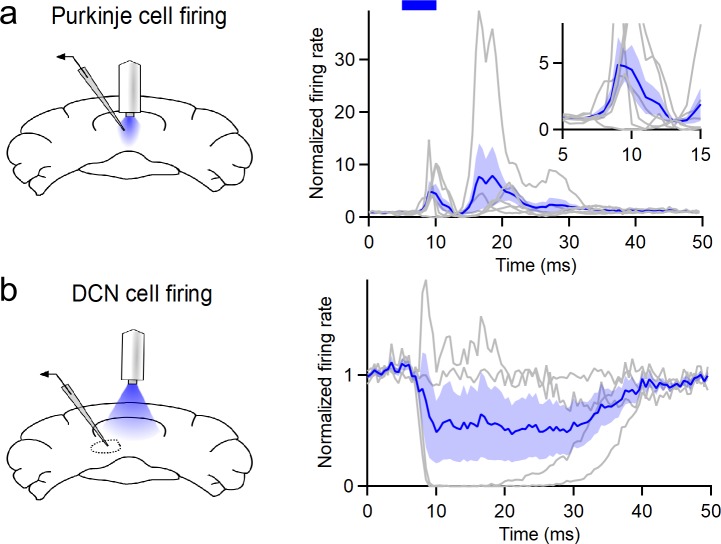
Millisecond-scale analysis of firing rates induced by in vivo stimulation in PCP2-cre::Ai32 animals.(a) Peristimulus time histogram (0.5 ms bins) of Purkinje cell firing induced by optical stimulation (20 Hz, 5 ms flashes). Inset shows PC responses from the beginning of light onset. (b) As in (a), but for DCN recordings. These recordings represent the same data shown in Figure 1. Individual units are in gray, the mean ± SEM is displayed in blue.